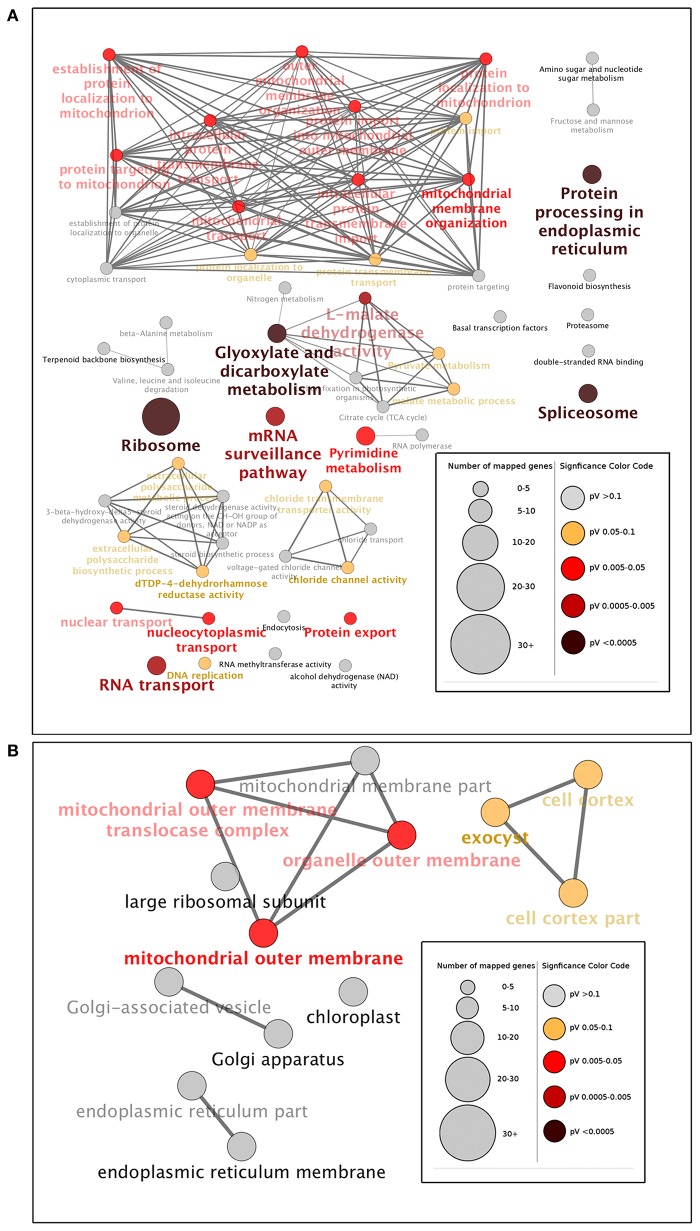
Gene Ontology (GO) enrichment analysis of identified proteins at the three- and six-leaf stages of maize Huangzao4 (HZ4) and H496 grown under long-photoperiod conditions. Different expressions of the protein interactome at the three- and six-leaf stages of HZ4 and H496 was analyzed using the Cytoscape plug-in ClueGo + Cluepedia to identify statistically enriched GO categories compared with the ClueGO maize reference genome. (A) GO categories searched include biological processes, molecular function, KEGG pathways, and (B) cell component. Nodes represent a specific GO term and are grouped based on the similarity of their associated proteins. Each node represents a single GO term and is color-coded based on enrichment significance (pV = p-value). Node size indicates the number of proteins mapped to each term. Edge thickness represents the calculated kappa score based on the number of proteins shared between terms. Functional groups are labeled by the most significant term in the group. Arrow indicates positive regulation.